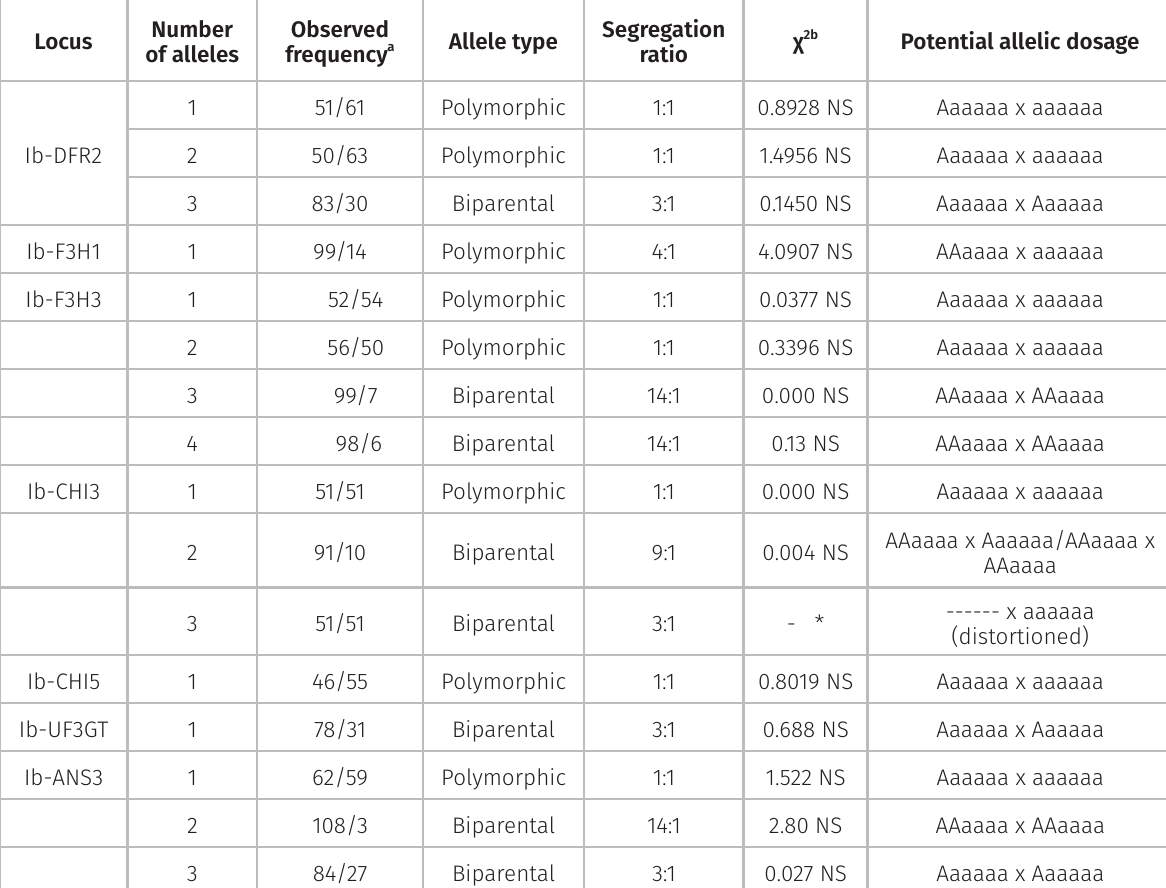
Table V. Segregation ratio and putative allelic dosage in Ipomoea batatas with ILP-GC markers. Number Observed Locus Allele of alleles frequency a